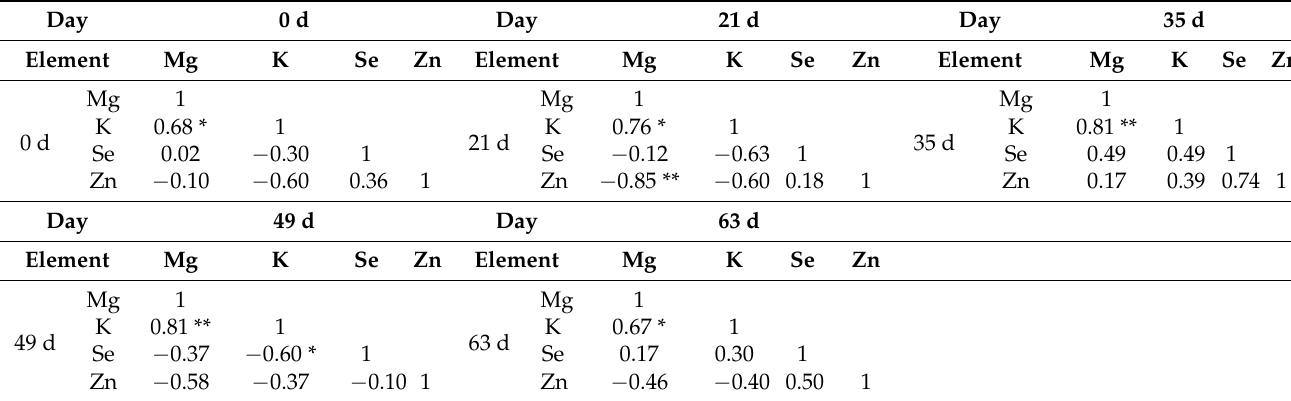
Table 4. Correlation between the depositions of mineral elements in the thigh